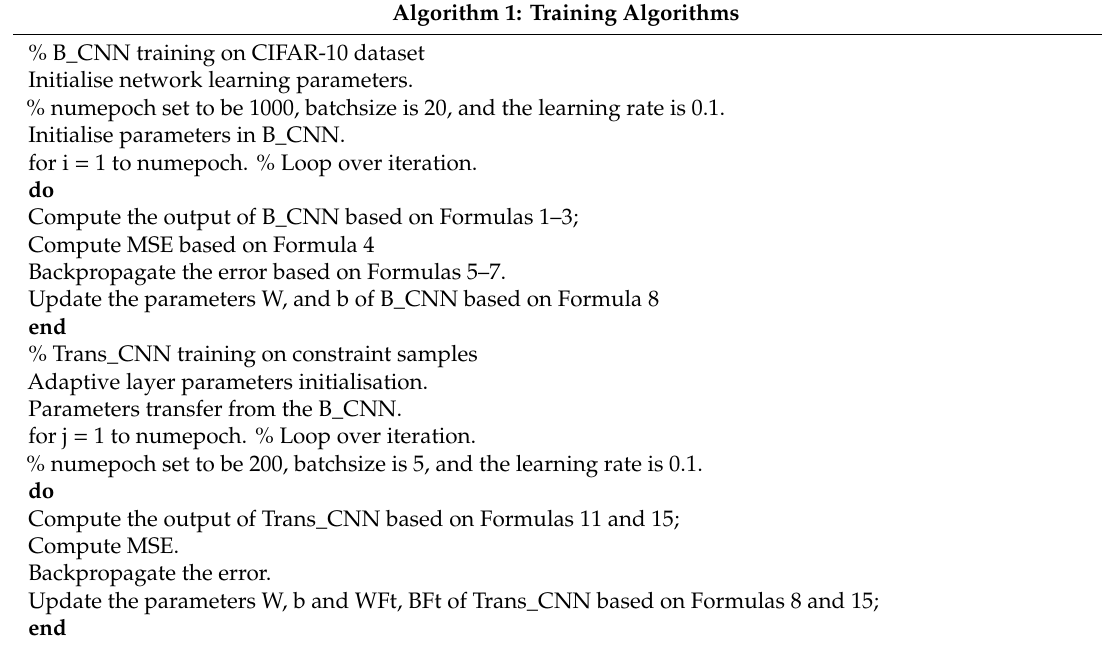
Table 1. The training steps for B_CNN and Trans_CNN. Algorithm 1: Training